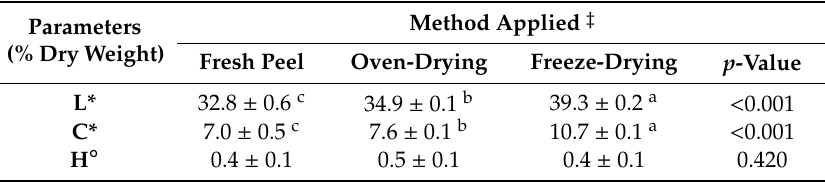
Table 2. E ff ect of the drying process using conventional oven-drying and the freeze-drying considering lightness (L*), hue angle (H ◦ ), and chromaticity (C*) parameters of the BRS magna grape skin